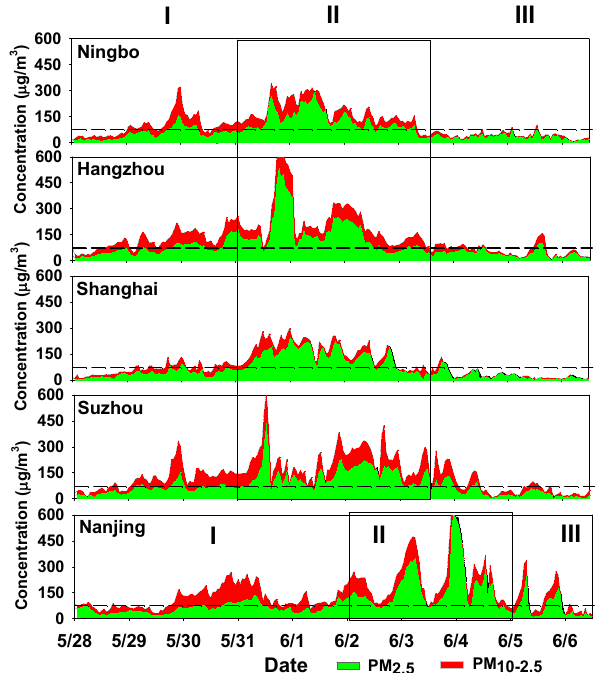
Fig. 2. Evolution of TEOM PM 2.5 (green) and PM 10 – 2.5 (red) mass concentrations during the monitoring period. The black lines show different phases described in the text. The horizontal long dash line represents the level of 75 µg/m 3 (the China’s national standard).